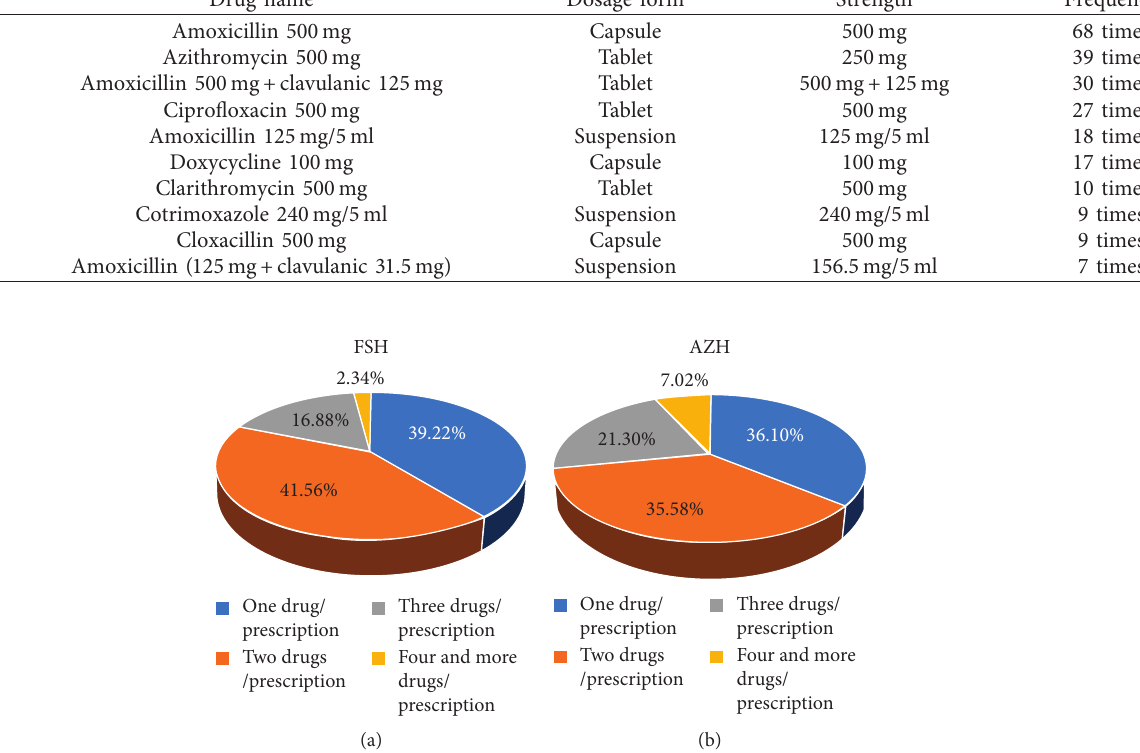
Table 2: List of drugs frequently prescribed in FSH, northwest Ethiopia, from October 11 to November 30, 2019. No.